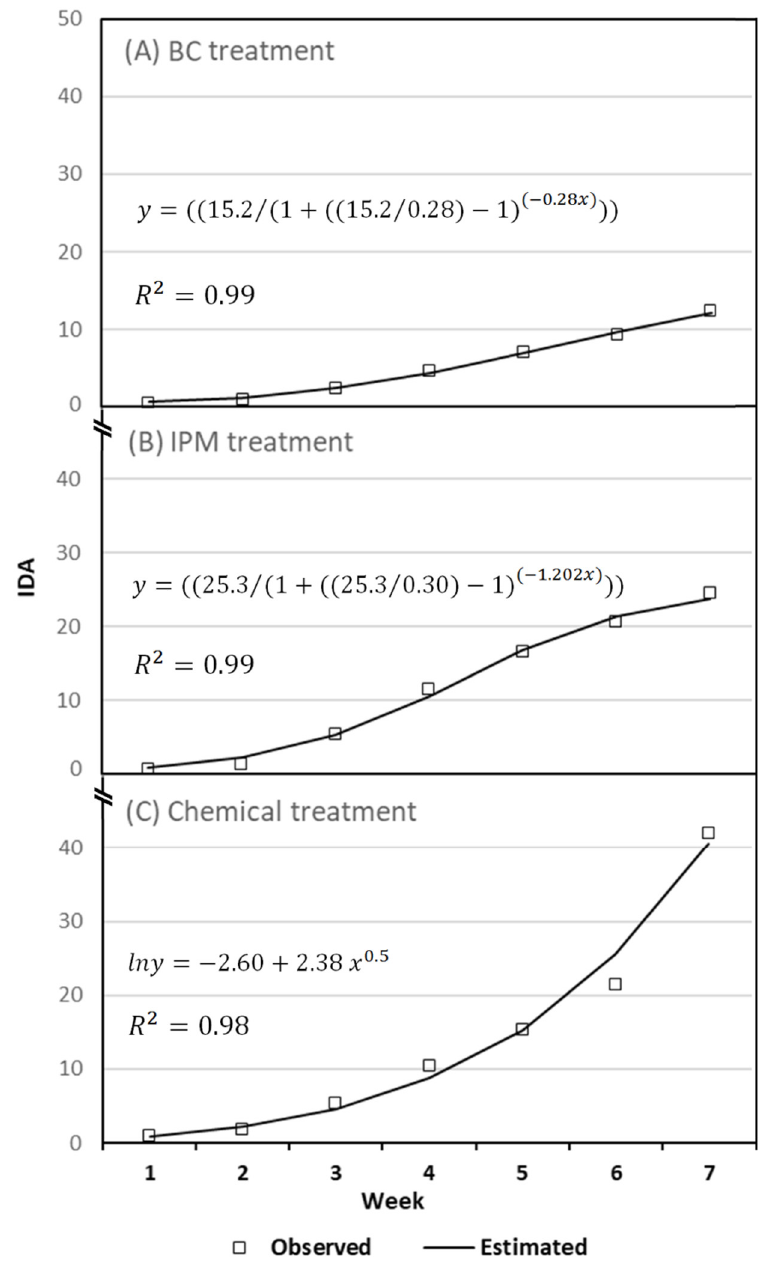
Figure 4. Mean insect-day accumulated values (IDA) of adults of B. tabaci under biological ( A ), integrated ( B ), and chemical ( C ) control strategies from experimental data (□) and predicted values ( ▬ ) by nonlinear functions. The cumulative experimental data under biological ( A ) and integrated ( B ) strategies fitted to a logistic equation and that under chemical strategy ( C ), to an exponential equation .